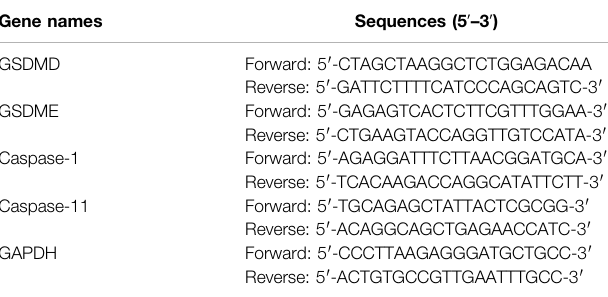
TABLE 1 | Primers for RT-PCR used in the present study.